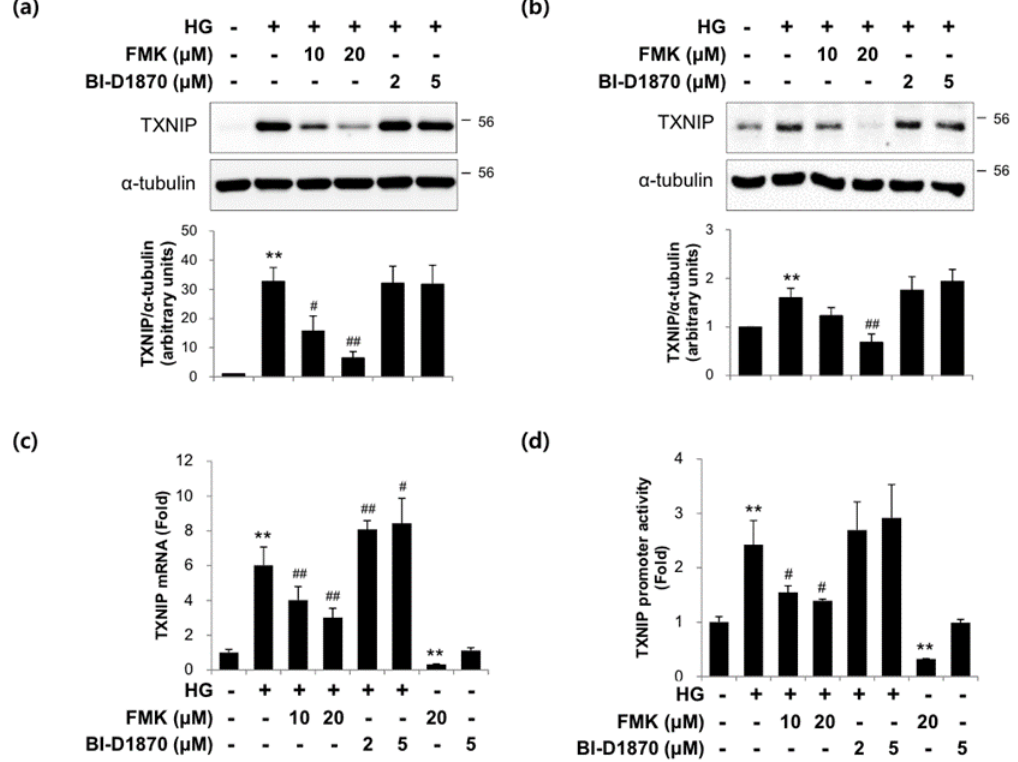
Figure 3. FMK (a CTKD inhibitor of p90RSK) inhibited TXNIP expression, but not BI-D1870 (a NTKD